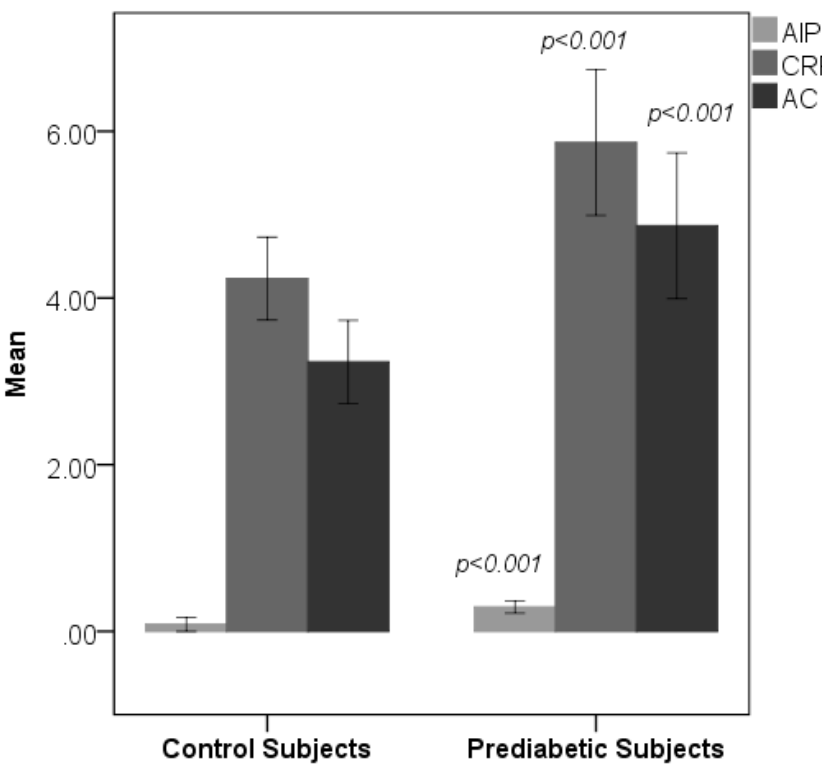
Figure 2. Comparison of atherogenic indices between control and prediabetic subjects. Atherogenic index of plasma (AIP) cardiac risk ratio (CRR) and atherogenic coefficient (AC). Table 2. Shows correlation of AIP, CRR, AC, and CIMT with cardiovascular risk factors in prediabetic subjects.